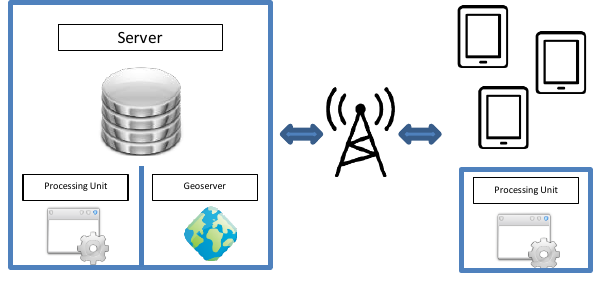
Figure 9. System architecture of mobile solution Fig. 9 shows the system architecture of the mobile